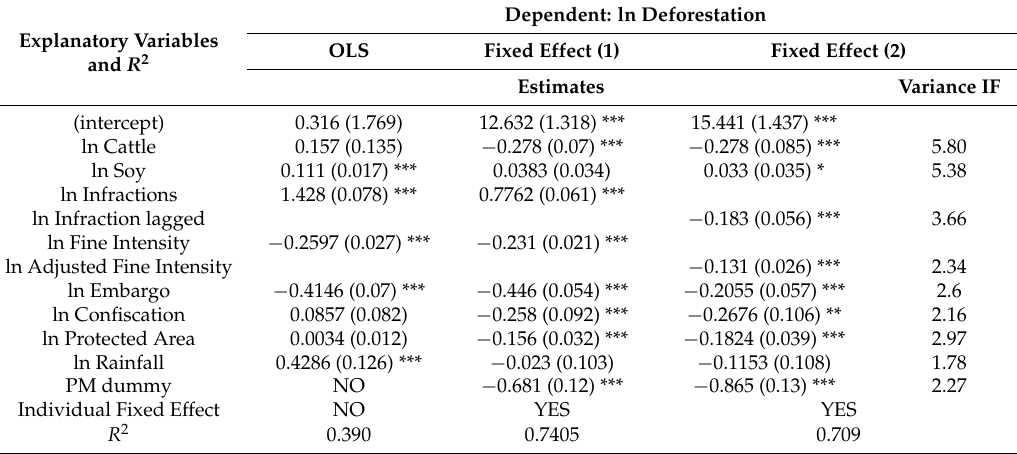
Table 6. Impact of deforestation causative and deterrent